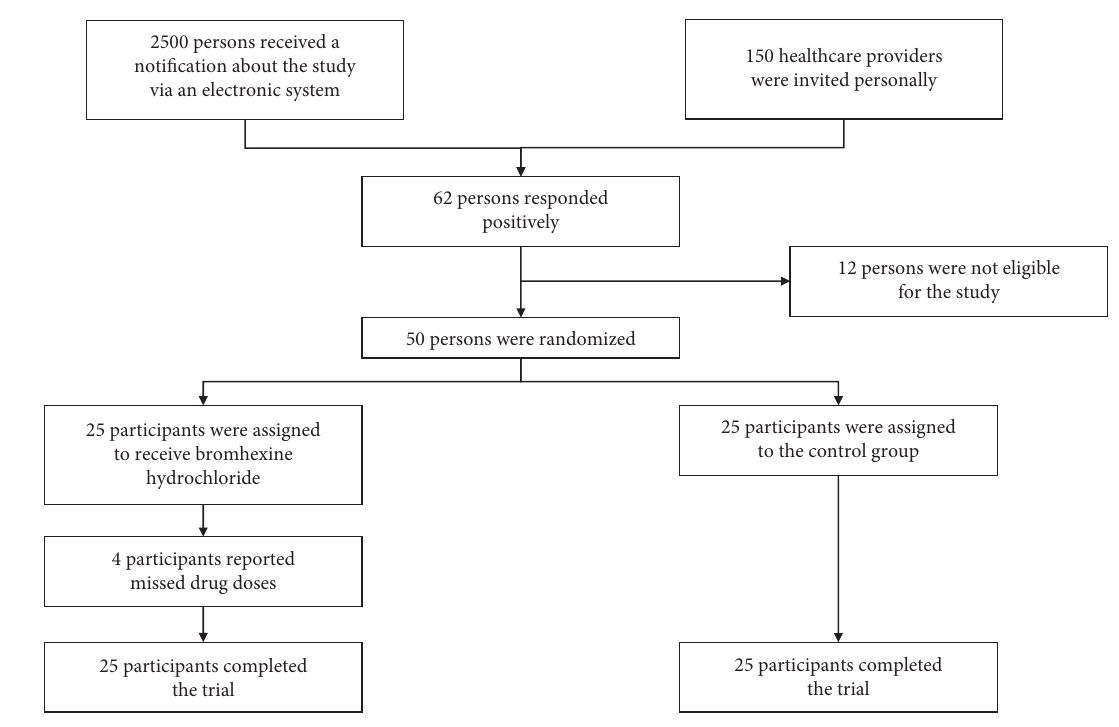
Figure 1: Study Table 1: Demographic, clinical, and work characteristics of study participants. Bromhexine treatment group